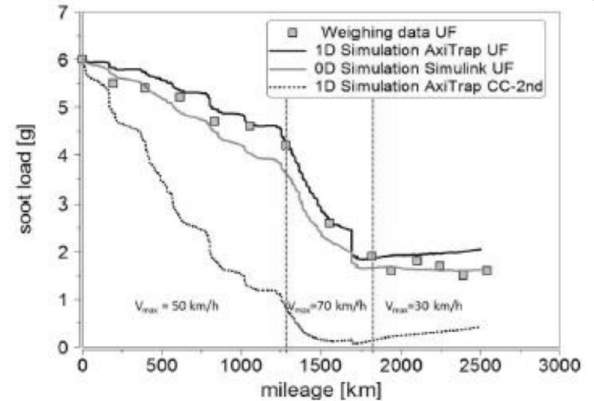
Fig. 8. Measured and simulated burning of soot in under-floor GPFs for three different average speed regimes